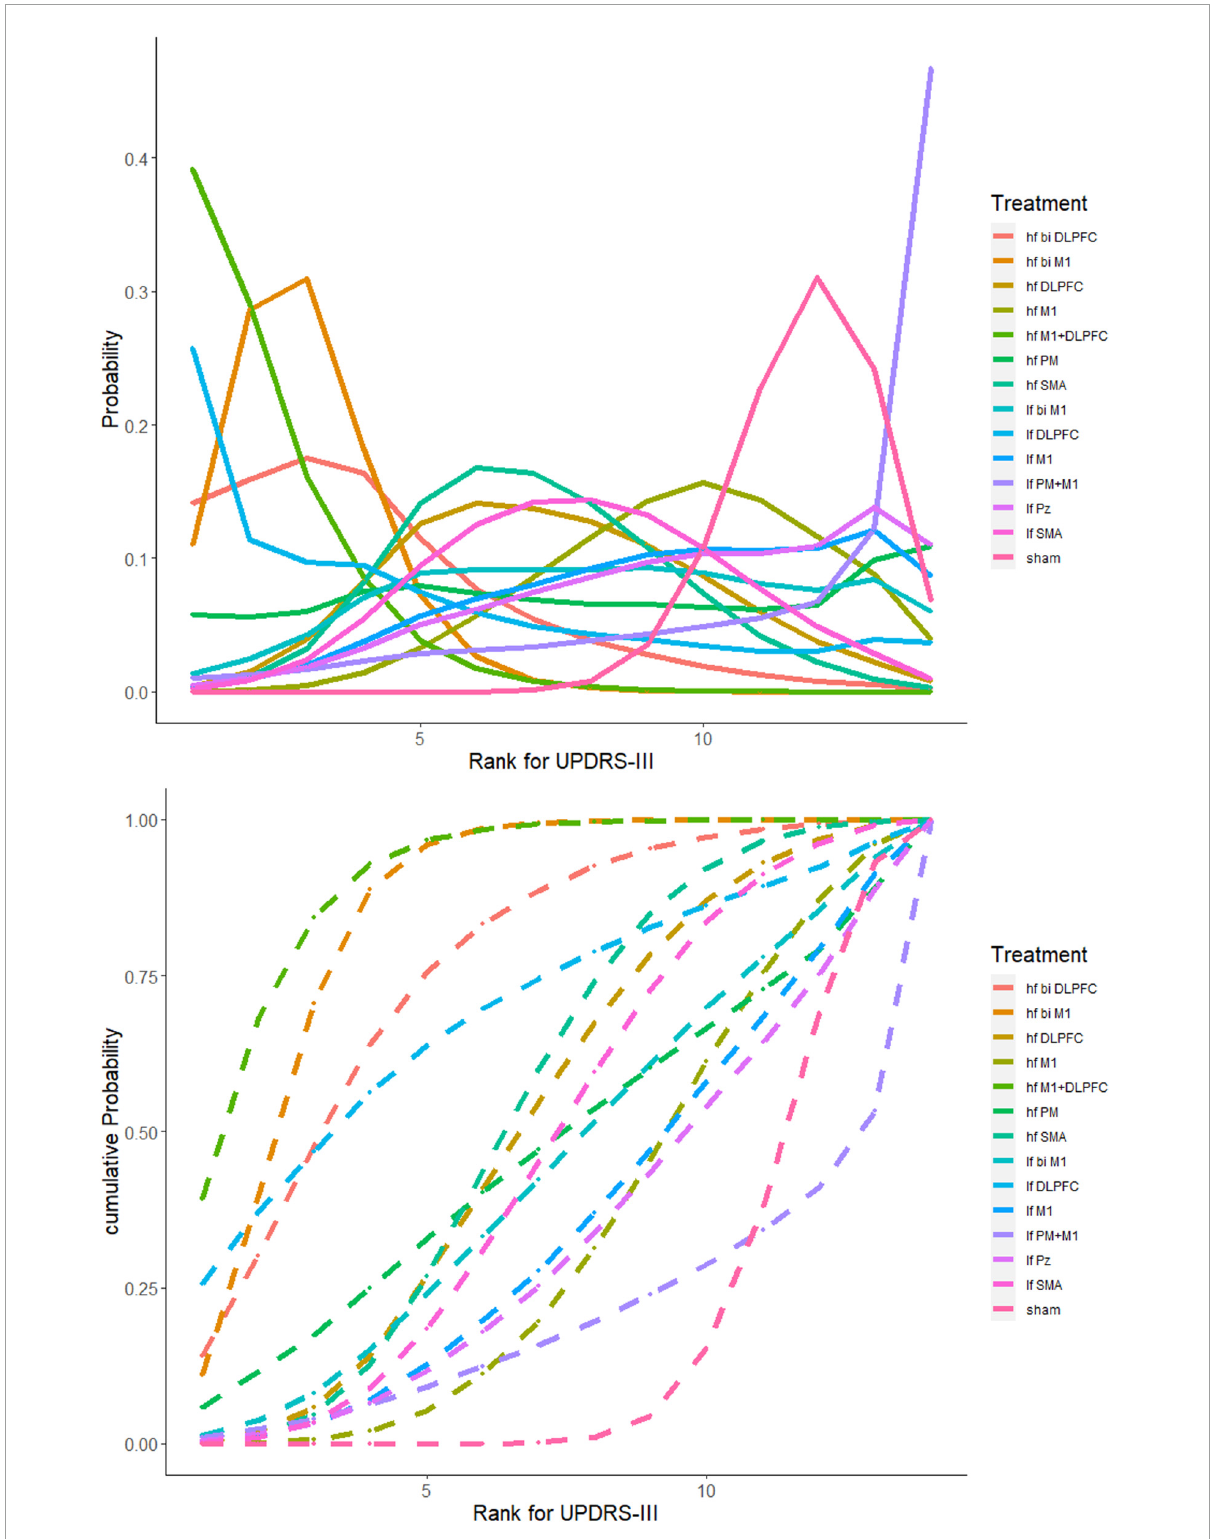
FIGURE5 The rankogram and cumulative ranking plot. [ (Top) : The rank probabilities of each parameter. (Bottom) : The cumulative ranking plot to present SUCRA value. The hf M1+DLPFC (green line) has the highest probability of being ranked first (39.14%) and had the highest SUCRA value (90.66%)].